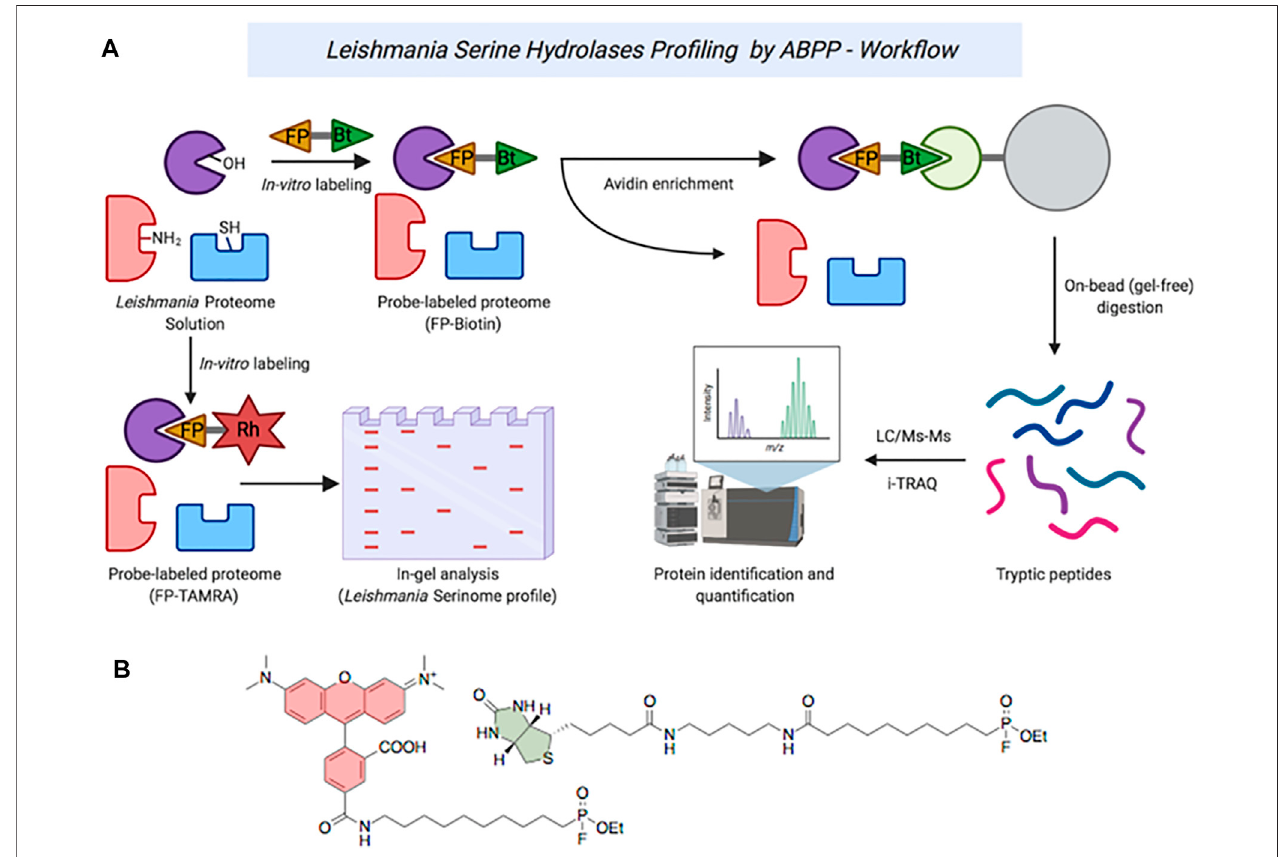
FIGURE 1 | (A) ABPP work fl ow of serine hydrolases in Leishmania spp. (B) : Structures of TAMRA-FP (red) and FP-Biotin